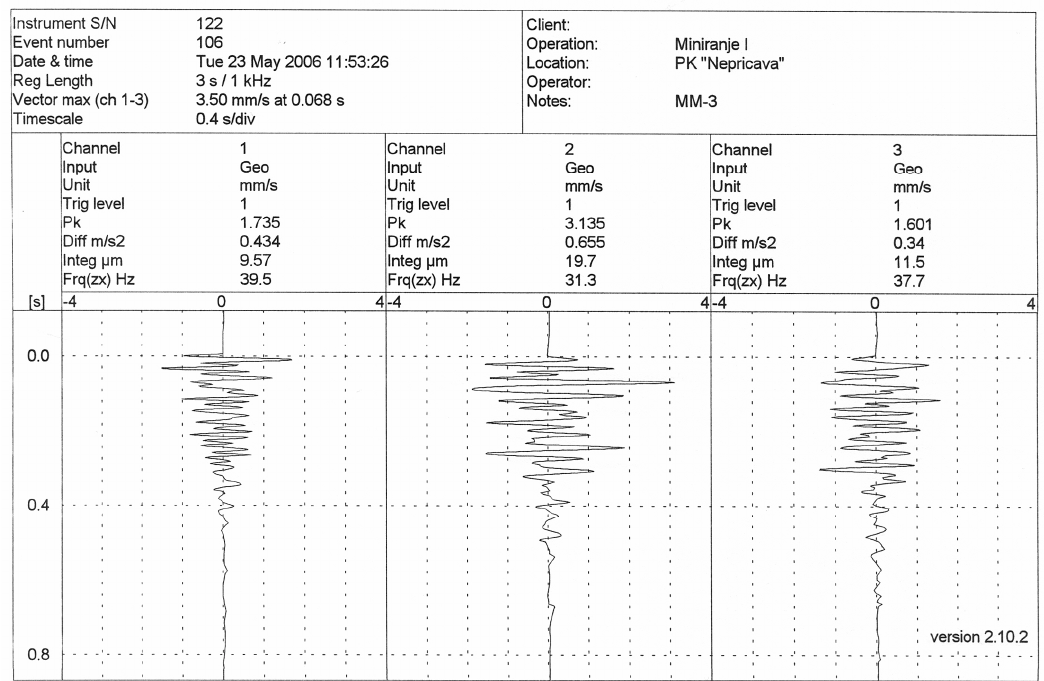
Figure 1. Recording of oscillation velocity of the ground intended for blasting No. I—measuring point No. 3 at PK Nepri č ava.